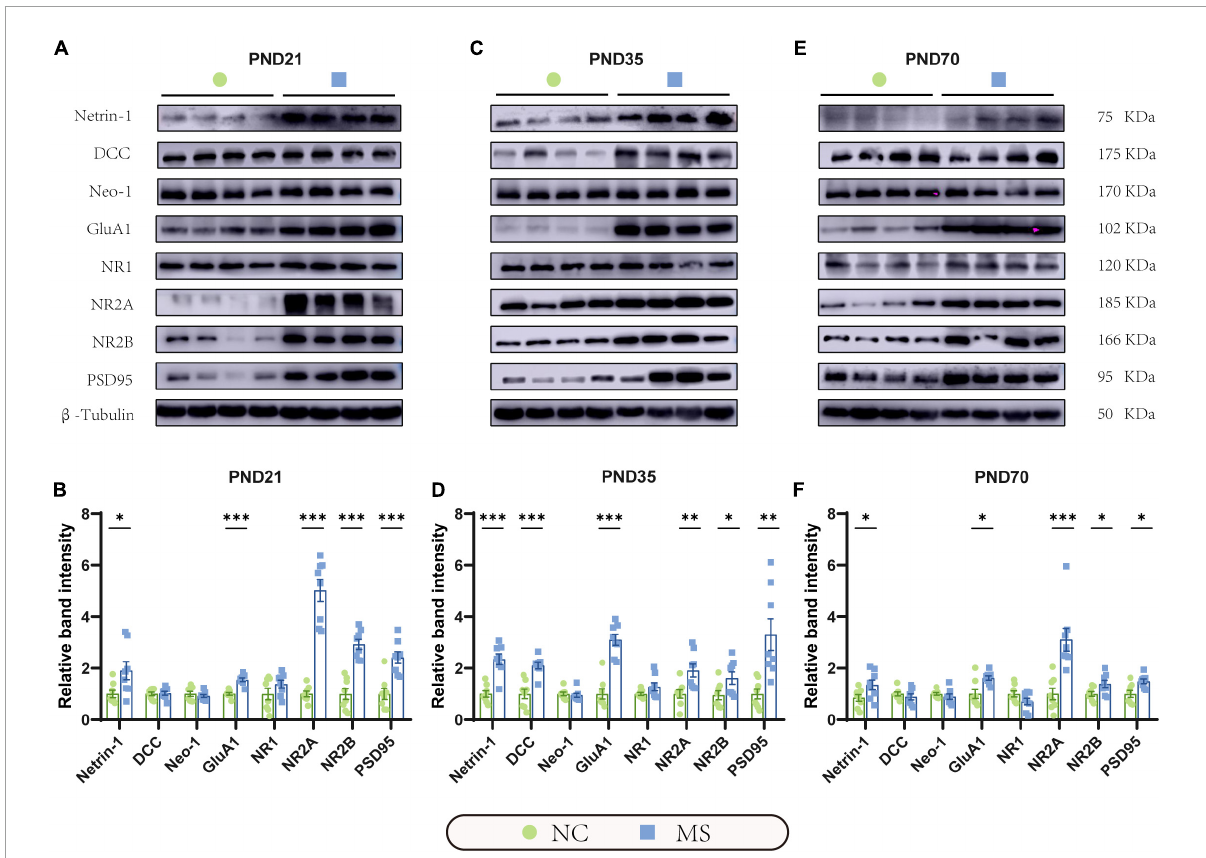
FIGURE6 Netrin-1 and GluA1 protein were upregulated in the hippocampus in rats of three MS groups. Representative immunoblots showed the expression of Netrin-1, DCC, Neo-1, GluA1, NR1, NR2A, NR2B, PSD95, and β -Tubulin on PND21 (A) , PND35 (C) , and PND70 (E) . (B) Western blot analysis showed increased expression of Netrin-1, GluA1, NR2A, NR2B, and PSD95 in the hippocampus in MS rats on PND21, (D) PND35, and (F) PND70. Furthermore, the protein expression level of DCC was upregulated on PND35. On PND21: NC, n = 8; MS, n = 8. On PND35: NC, n = 8; MS, n = 8. On PND70: NC, n = 8; MS, n = 8. All data were given as mean ± SEM. ∗ P < 0.05, ∗∗ P < 0.01, ∗∗∗ P < 0.001, two-tailed unpaired Student’s t